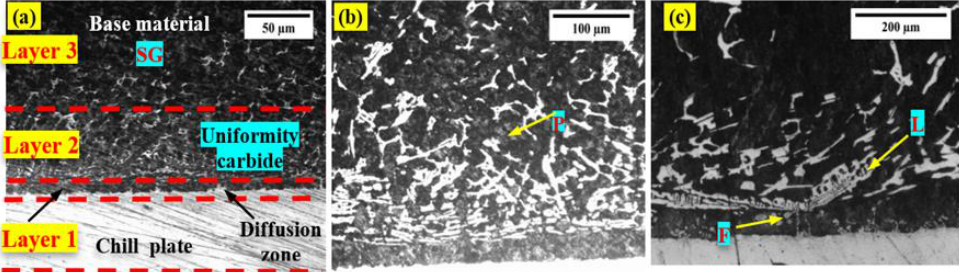
Figure 6: Average microstructure formation on the surface of the samples (S1). (a. Sample S1 microscopic magnification 50x; b. microscopic magnification 100x; c. microscopic magnification 200x). P=perlite; L=ledeburite; F=ferrite; SG=spheroidal graphite).